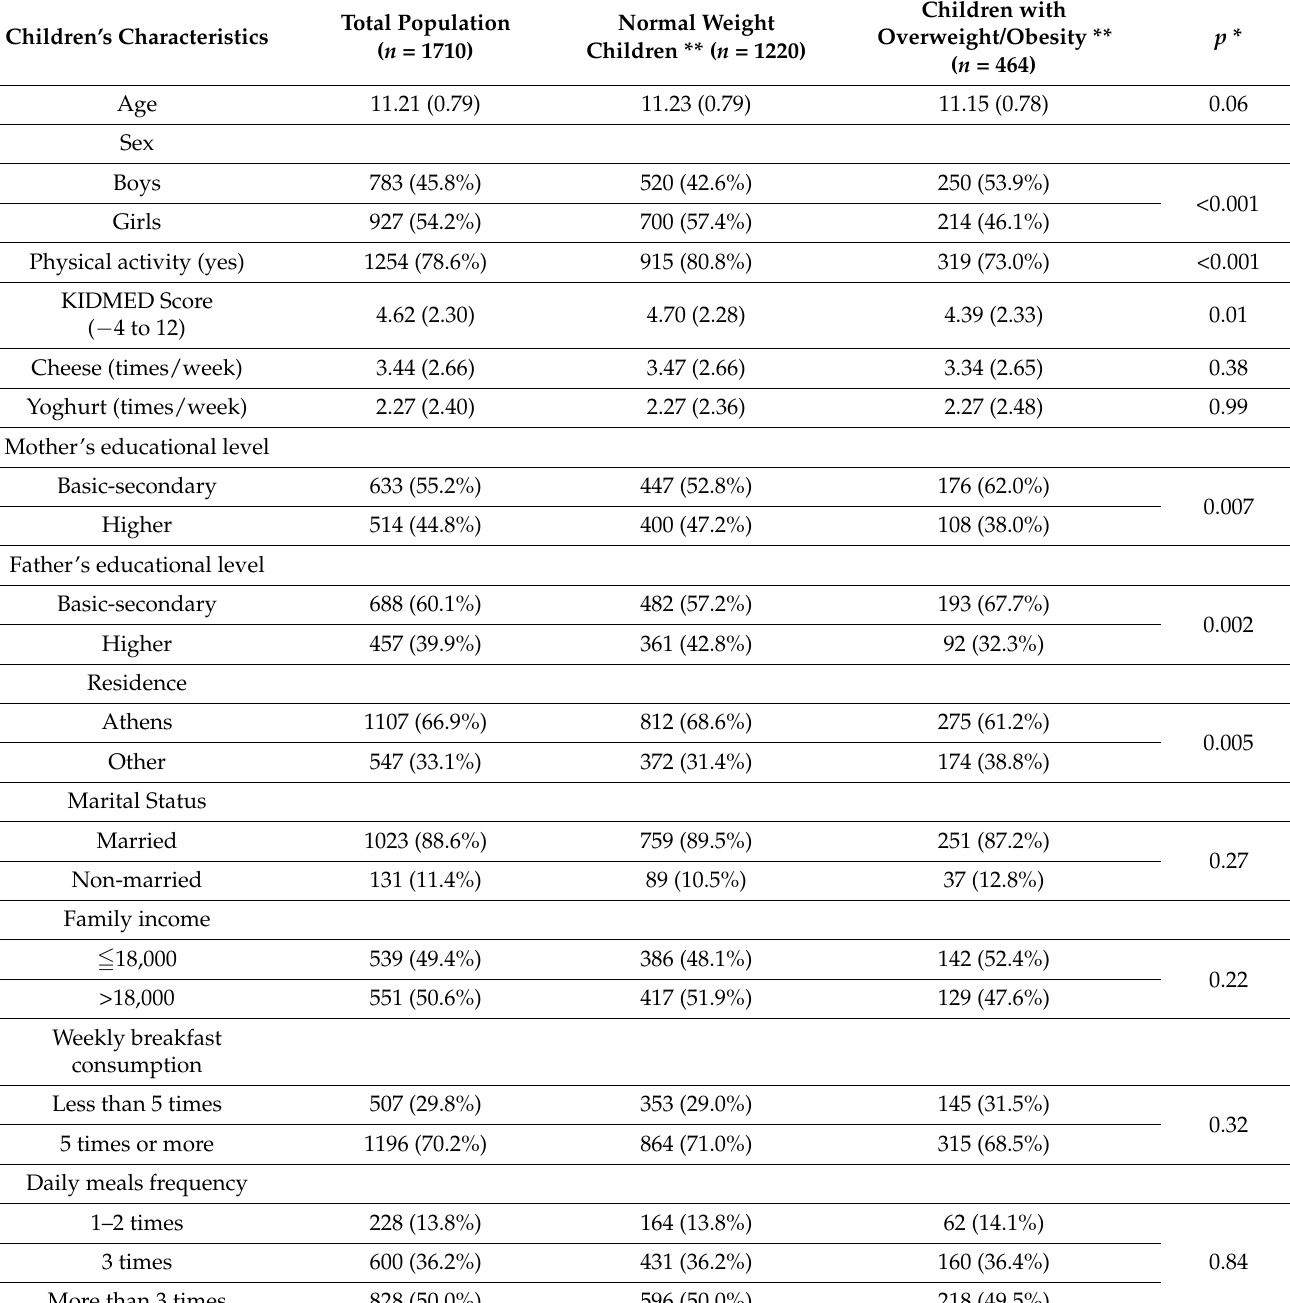
Table 1. Children’s socio-demographic characteristics and lifestyle habits, by body weight